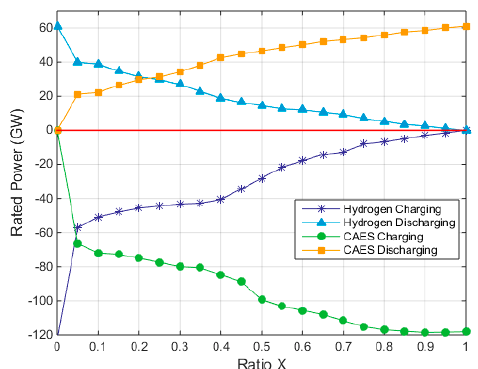
Figure 11. Variation in the rated charging and discharging powers of both types of stores with re- spect to